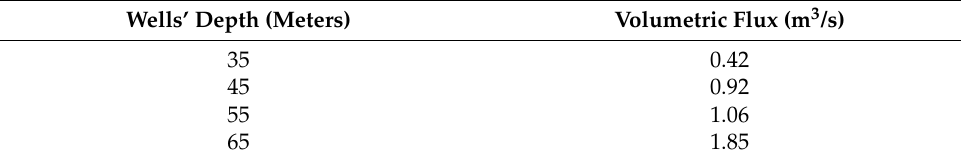
Table 2. Maximum infiltration volumetric fluxes for different depths during the first 12 h.